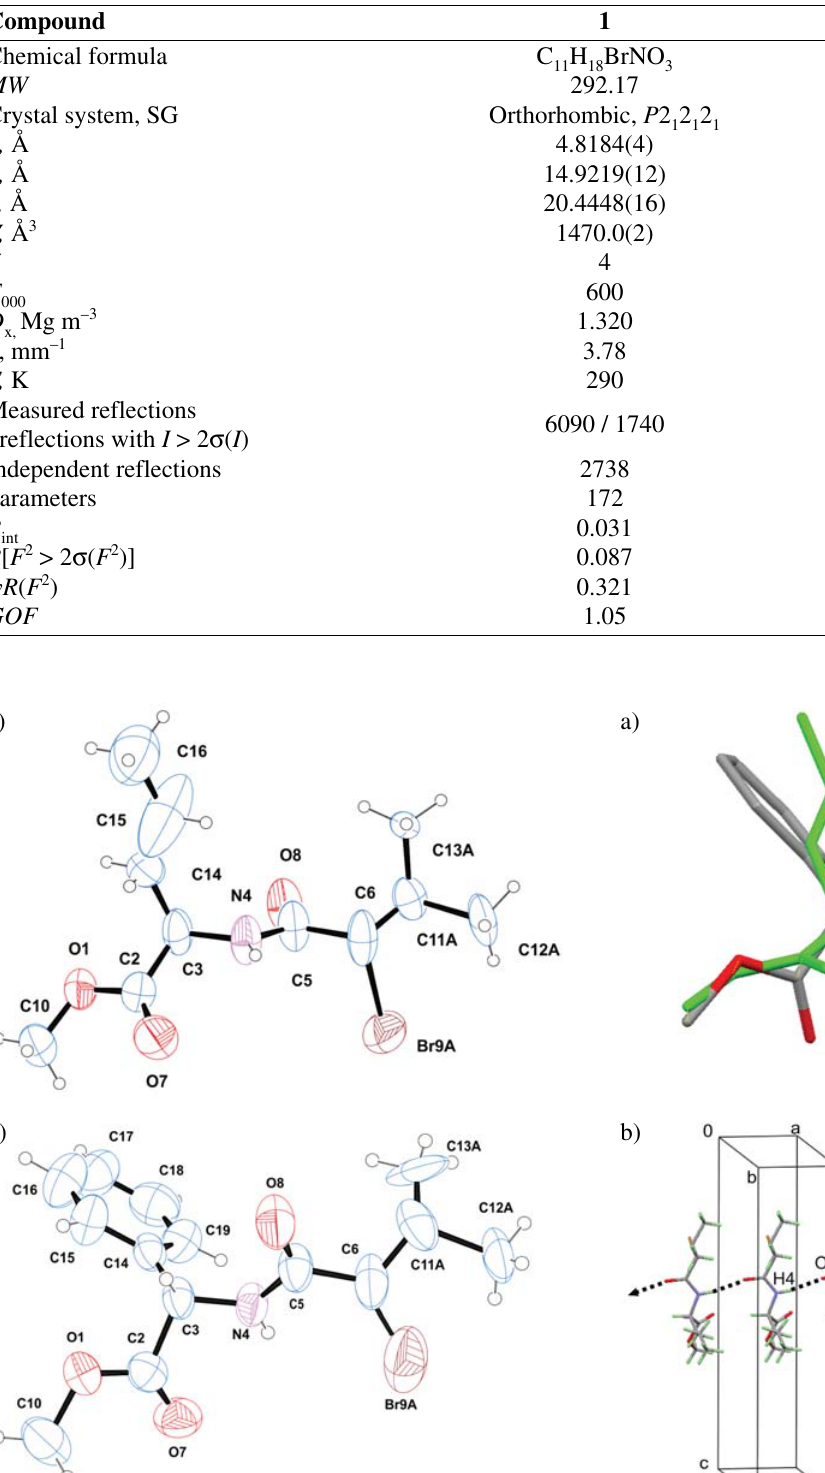
Table 1. Important crystallographic and refinement details for 1 and 2